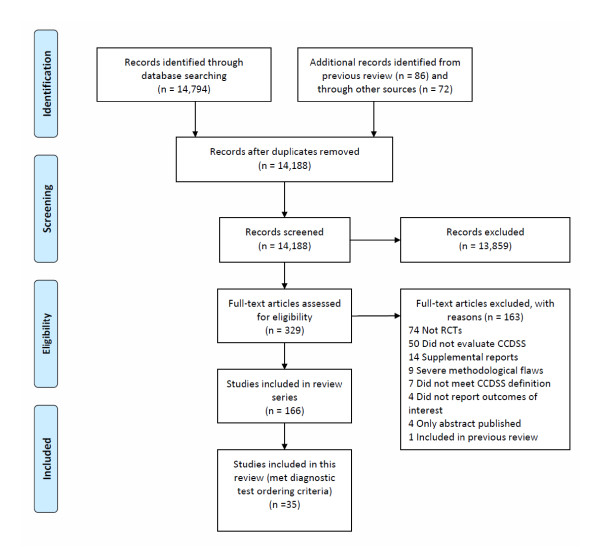
Flow diagram of included and excluded studies for the update 1 January 2004 to 6 January 2010 with specifics for diagnostic test ordering*. *Details provided in: Haynes RB et al. [20]. Two updating searches were performed, for 2004 to 2009 and to 6 January 2010 and the results of the search process are consolidated here.